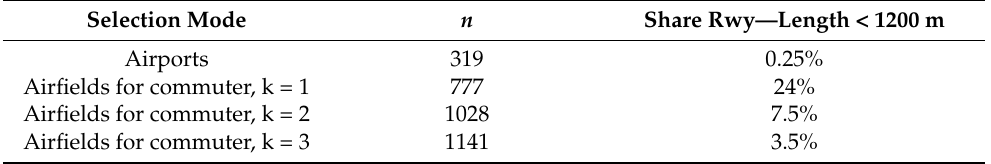
Table 2. Quantity of distinct and unique different airports ( n ) and the share of runways shorter than 1200 m for the studied airport/airfield selection